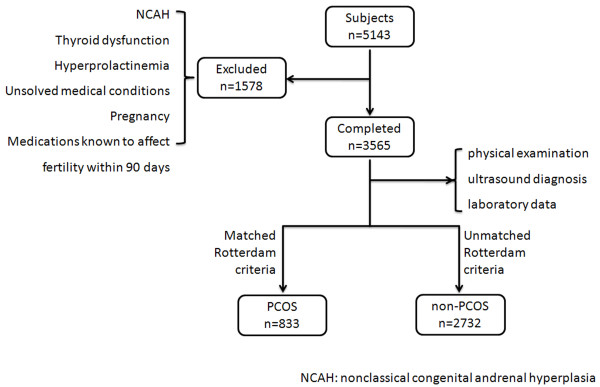
Route diagram of the present prevalence study.